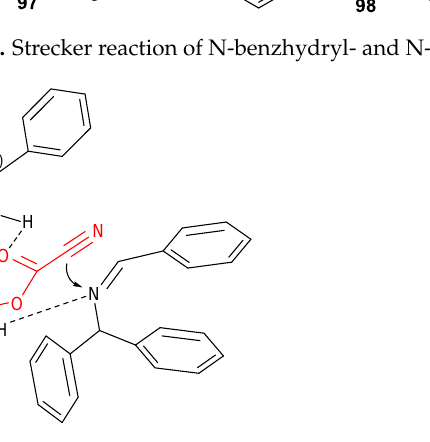
Figure 11. Proposed stereoselection model for the hydrocyanation of imines.